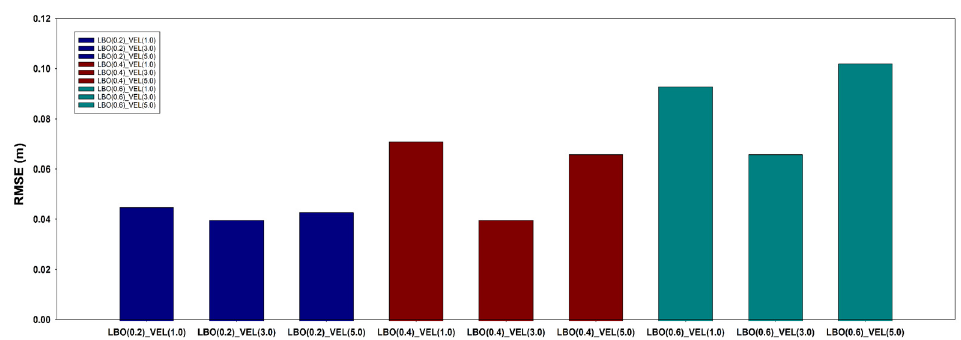
Figure 14. Flight accuracy by flight variable.